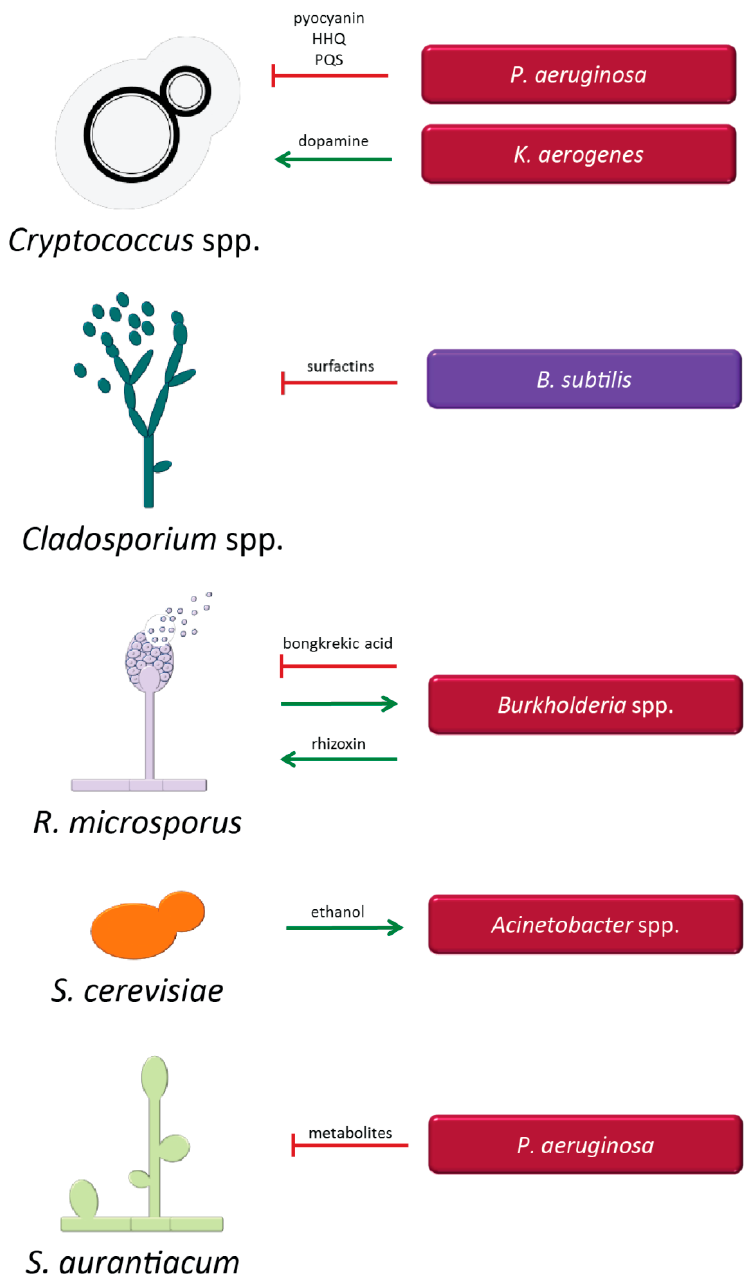
Figure 3. Molecules and factors mediating the interaction between Cryptococcus spp., Cladosporium spp., Rhizopus microsporus, Saccharomyces cerevisiae, Scedosporium aurantiacum , and di ff erent bacteria. Gram- positive bacteria are represented in lilac ( Bacillus (B.) subtilis ) and Gram-negative bacteria are represented in red ( Pseudomonas (P.) aeruginosa, Klebsiella (K.) aerogenes ). Green arrows indicate supportive interactions and red lines represent inhibitory e ff ects. If not indicated above the green arrows and red lines, the molecules mediating the interaction are currently